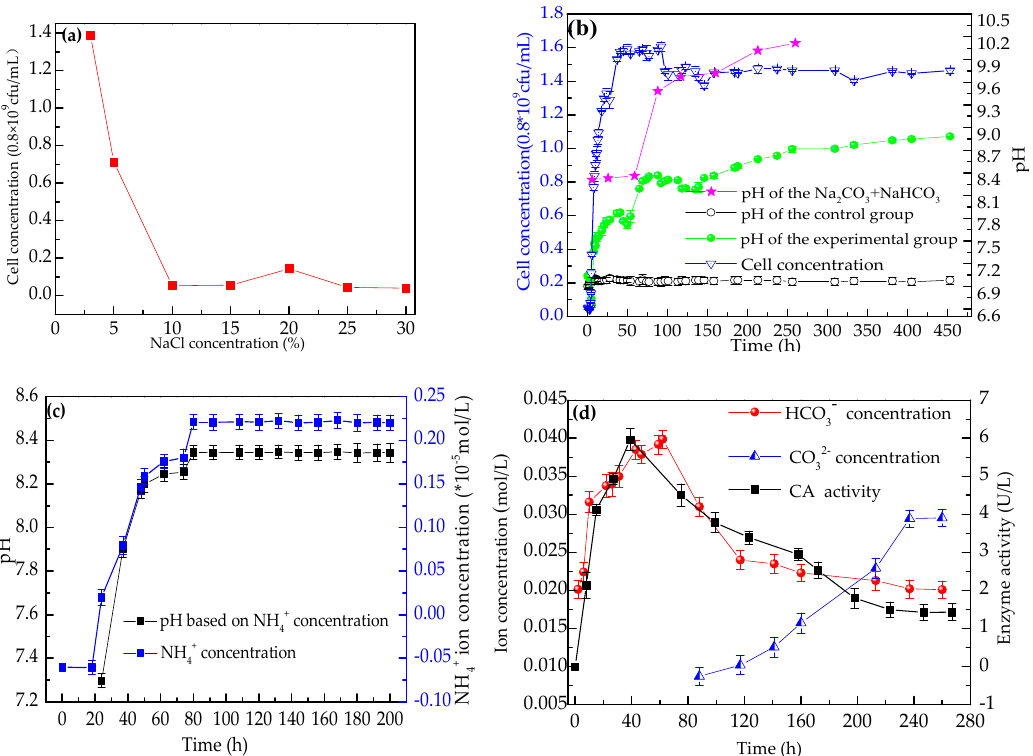
Figure 3. Physiological and biochemical characteristics of H. smyrnensis WMS-3 bacteria. ( a ) Growth curve of the H. smyrnensis WMS-3 bacteria at different NaCl concentrations after 24 h of cultivation; ( b ) Growth curve and pH changes; ( c ) NH 4+ concentrations and pH curve based on NH 4+ concentrations; ( d ) CA activity, and HCO 3 − , and CO 32 − ion concentrations.